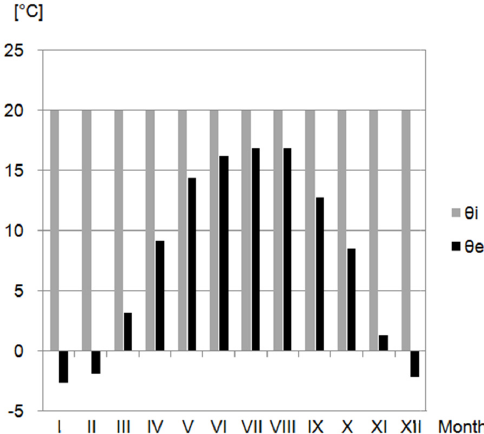
Figure 6. Indoor and outdoor temperature of the air